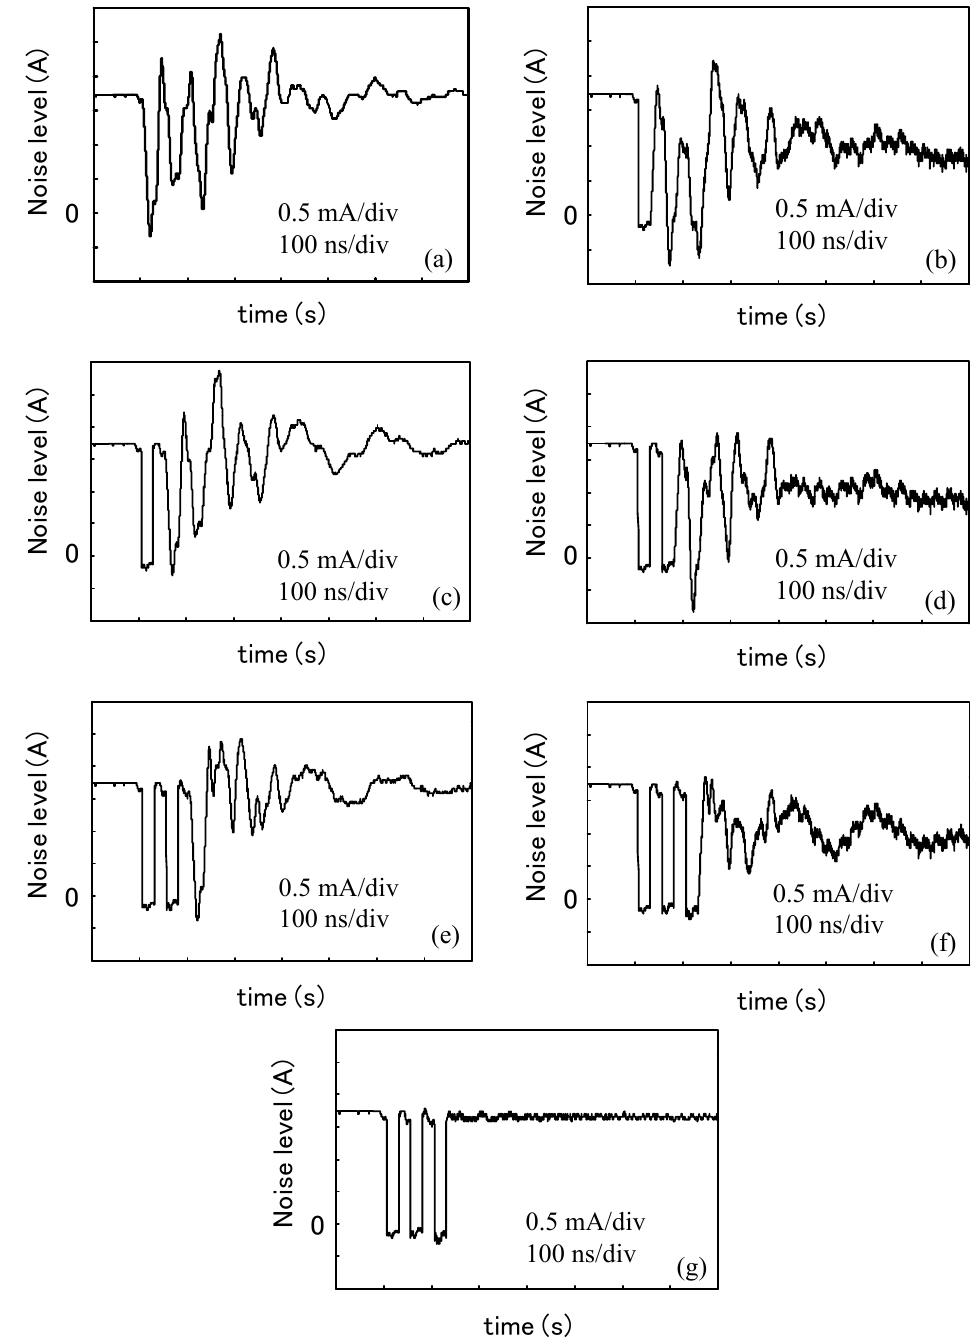
Figure 7. Common-mode noise waveforms of the signal processing: ( a ) before processing, ( b ) after processing for first down-step, ( c ) after processing for first up-step, ( d ) after processing for second down-step, ( e ) after processing for second up-step, ( f ) after processing for third down-step, ( g ) after processing for third up-step.